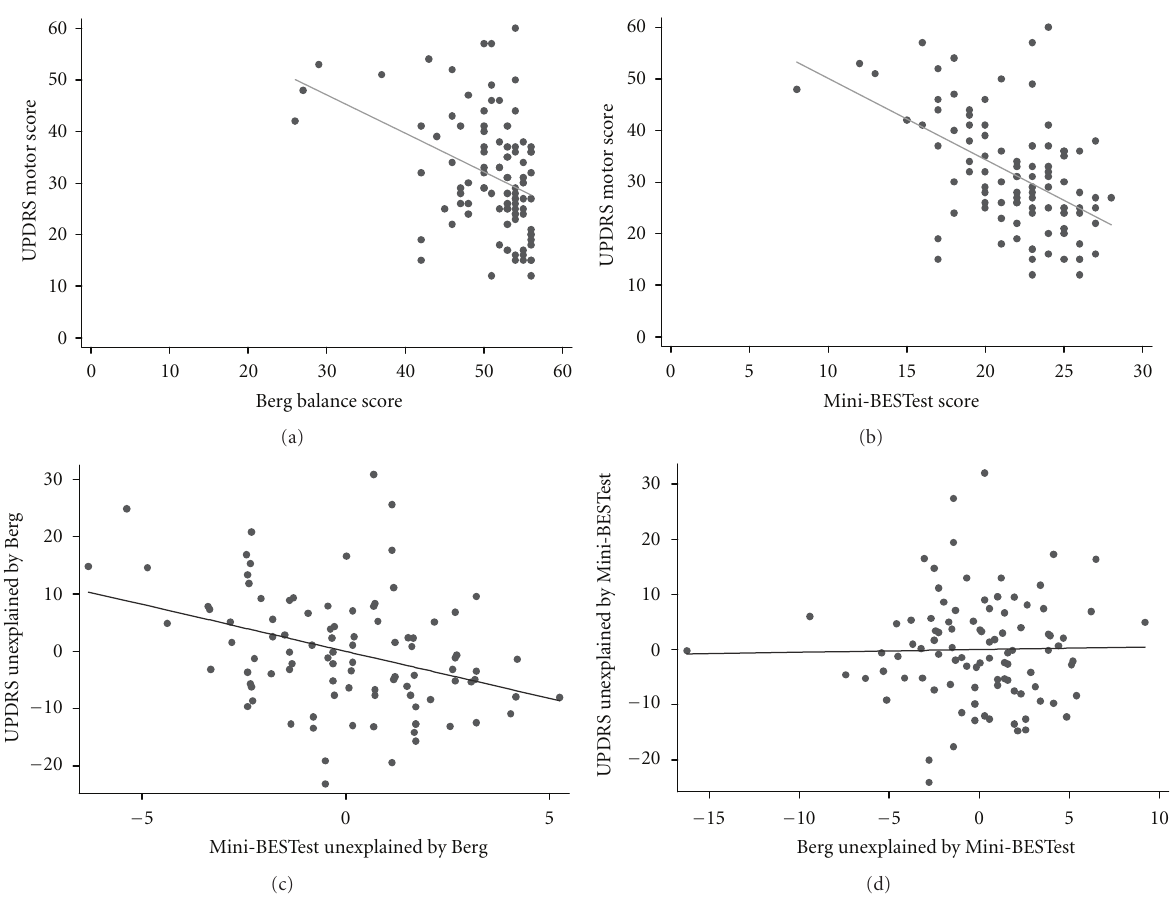
Figure 2: Scatter plots showing the relationship of the UPDRS motor score to (a) Berg Balance scale, and (b) Mini-BESTest score. Lower panels show (c) added value of the Mini-BESTest over Berg and, (d) added value of Berg over Mini-BESTest for predicting UPDRS motor